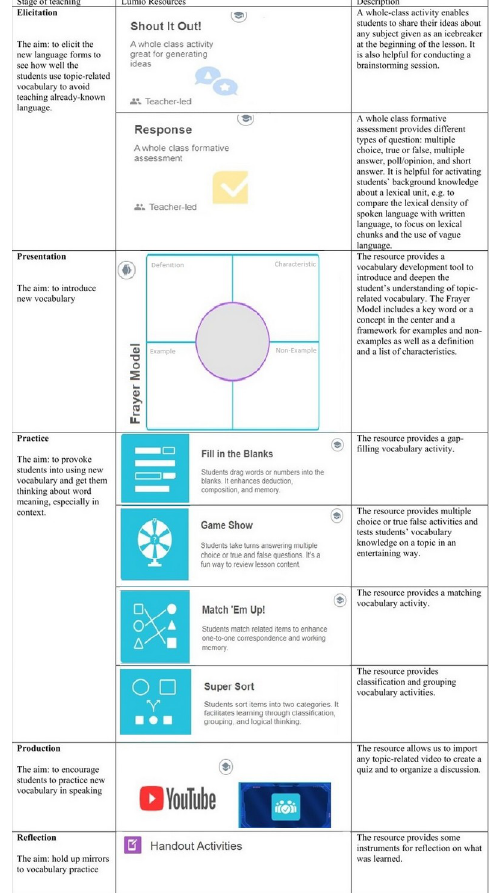
Figure 1 - The algorithm of teaching vocabulary via Lumio by